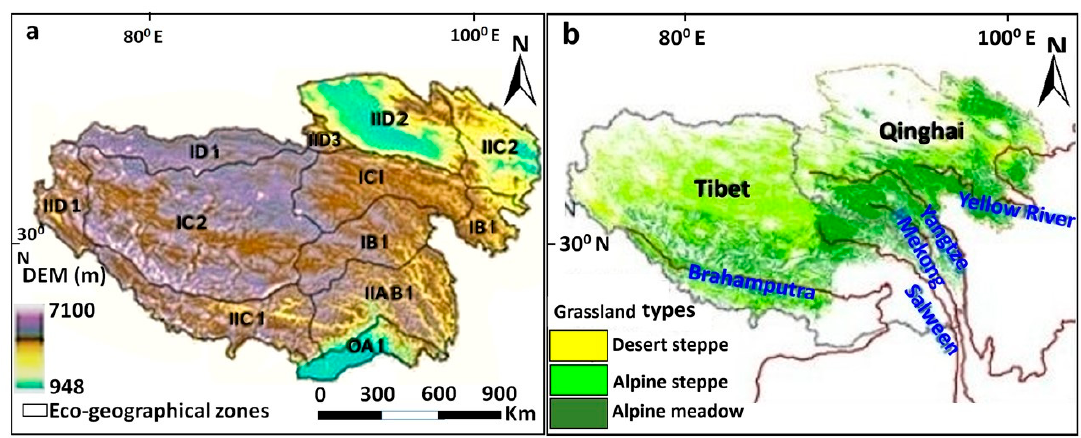
Figure 3. Map of Qinghai–Tibet Plateau showing ( a ) principal eco-geographical zones, elevation and ( b ) grassland types as well as the major rivers that arise on the Plateau. The relatively small areas of true alpine meadow are scattered throughout the lower altitude regions and are highly prized as grazing, especially by sheep herders (see photo 2).